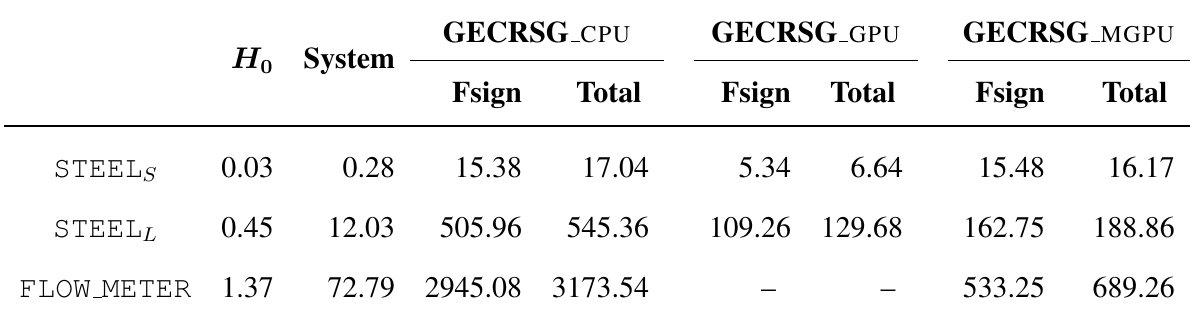
Table 3. Execution time (in seconds) for the solution of algebraic Riccati equations.